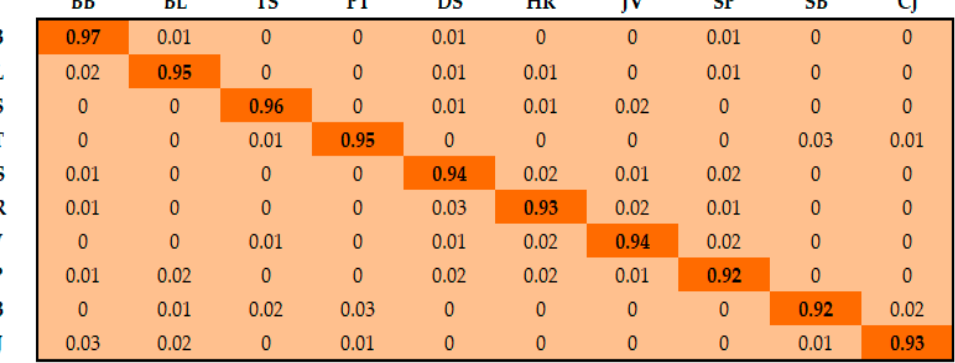
Figure 13. Confusion matrix of Olympic Sports dataset, BB = basketball, BL = bowling, TS = tennis-serve, PT = platform, DS = discus, HR = hammer, JV = javelin, SP = shot put, SB = spring board, CJ = clean jerk.